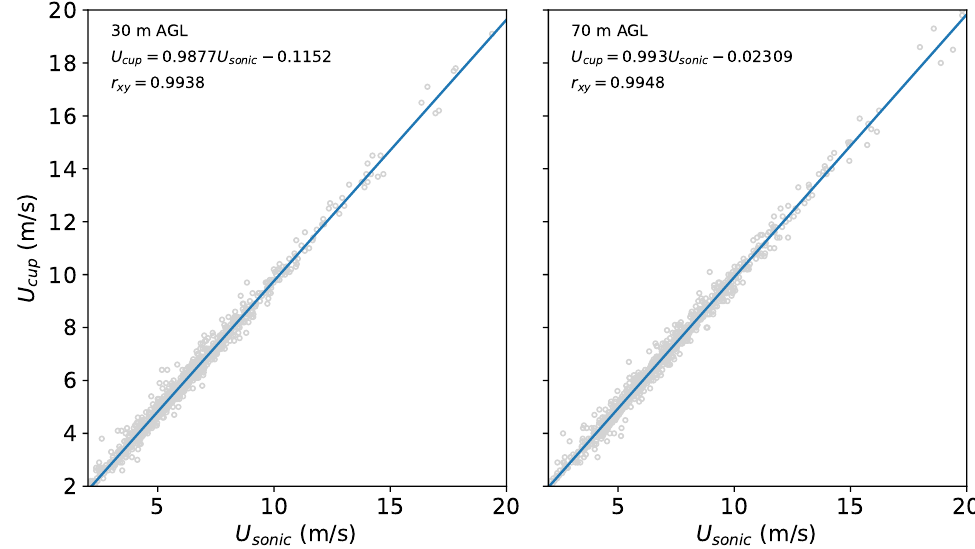
Figure 4. Comparison of the wind speeds from sonic anemometers ( U sonic ) and cup anemometers ( U cup ) for the wind direction in 0 ◦ ± 10 ◦ : measurements in symbols and fit curves in solid lines. r xy is the Pearson correlation